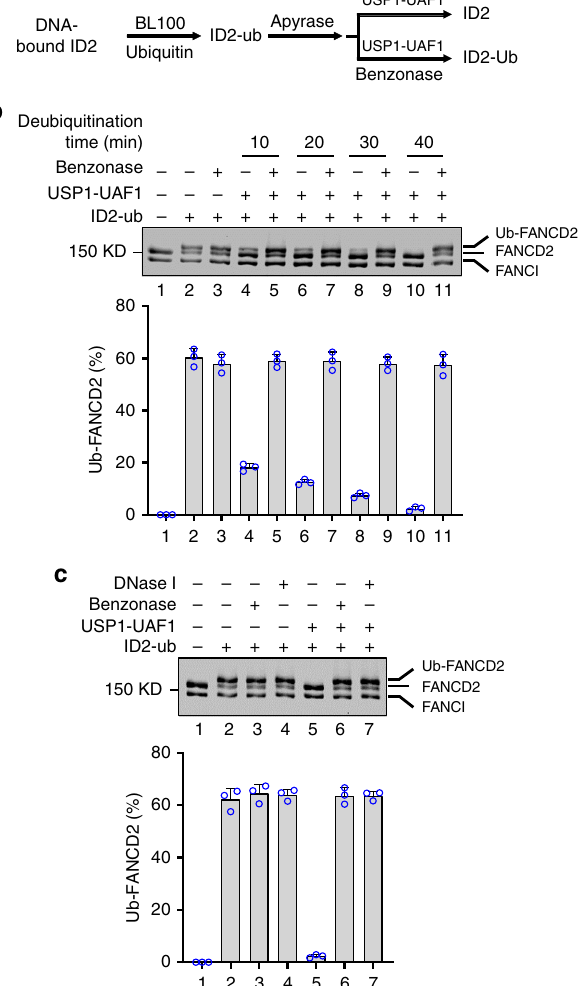
Fig. 1 Requirement for DNA in FANCD2 deubiquitination. a Schematic of ID2 ubiquitination and deubiquitination in our reconstituted system. b ID2 was fi rst incubated with BL100 to ubiquitinate FANCD2, followed by treatment with USP1-UAF1 without or with benzonase. The error bars represent the mean + S.D. of data from three independent experiments. c Either benzonase or DNase I treatment abolished FANCD2 deubiquitination by USP1-UAF1. The error bars represent the mean + S.D. of data from three independent